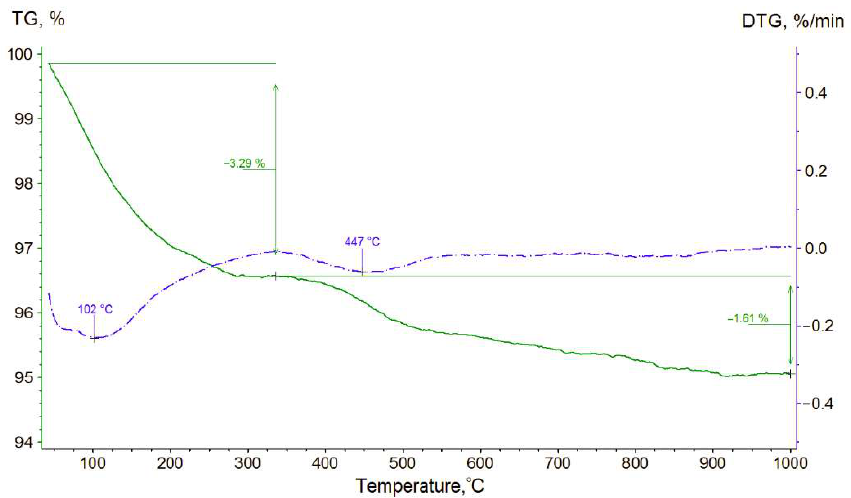
Figure 3. Characteristic graph of simultaneous thermal analysis for raw alumina nanofibers. The loss in mass on the TG and DTG plots, characterized by the minimum of the derivative plot at 102 °C, indicates the loss of water by the material, which, under normal conditions, is physically bound to the surface of nanofibers in the form of an adsorbate.